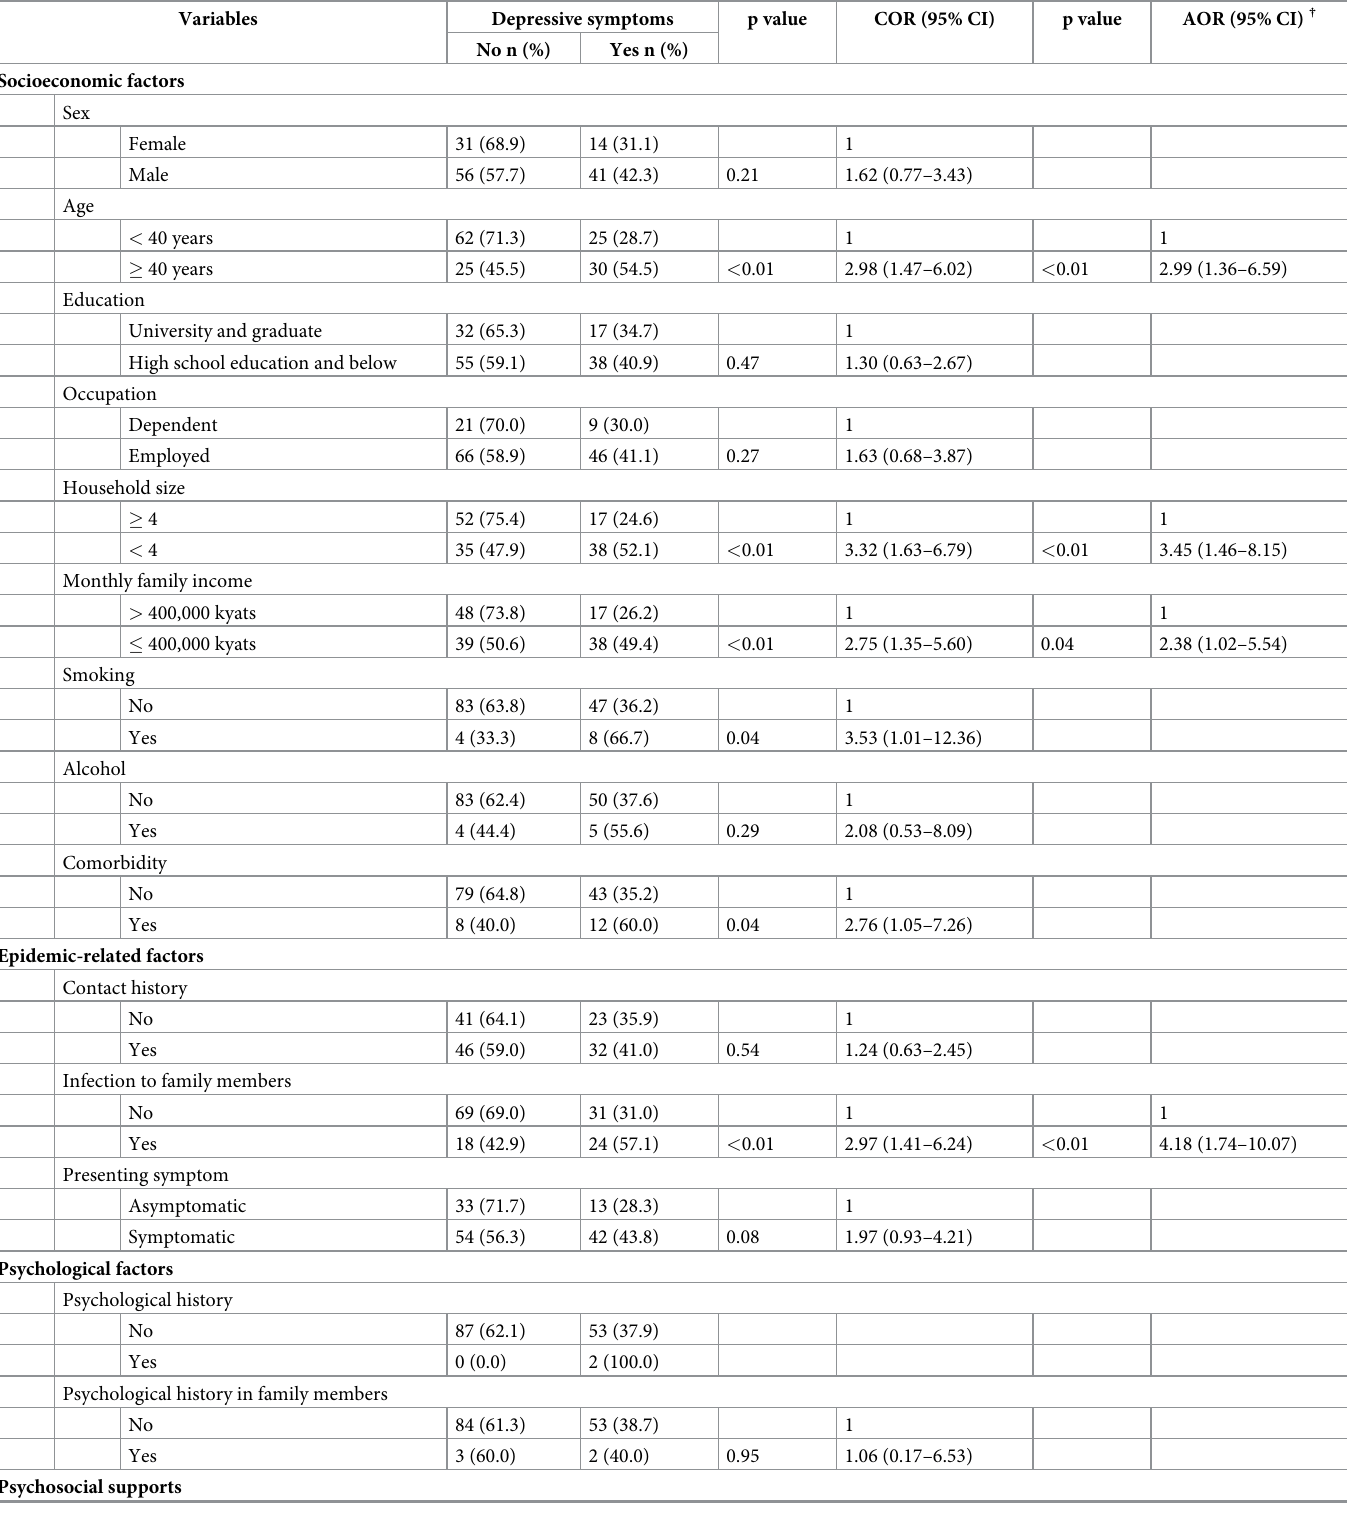
Table 4. Bivariable and multivariable logistic regression analysis of factors associated with depressive symptoms in patients with COVID-19.